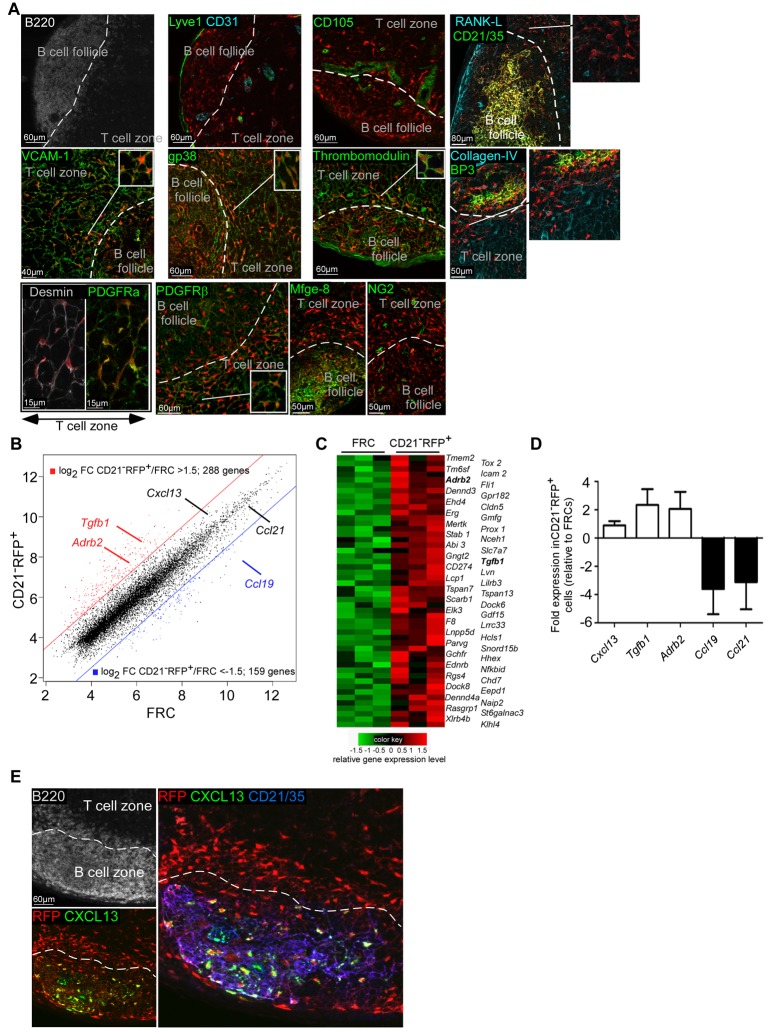
Phenotype of CD21− RFP+ stromal cells.(A and E) Confocal images of a LN section from a CD21cre-RFP chimera stained for the indicated markers. RFP+ cells appear in red. The dashed line delineates B cell follicle boundary. (B, C, D) CD21− RFP− gp38+ CD31− CD45− FRCs and CD21− RFP+ gp38+ CD31− CD45− cells were sorted by flow cytometry and their transcriptomic profiles were analyzed by microarrays (B and C) or RT-PCR (D). (B) Scatter plot of global comparison of gene expression between CD21− RFP+ cells and FRCs. Each gene in the microarray is represented by a dot with coordinates consisting of average gene expression computed from three independent CD21− RFP+ samples (y-axis) and from the three matched FRC samples (x-axis). Genes with Log2 average expression level at least 1.5-fold higher in CD21− RFP+ cells are shown in red, while genes with Log2 average expression level at least 1.5-fold higher in FRCs are shown in blue. These genes are separated from the other genes by colored lines representing these fold change cutoffs. (C) Heat map for the 50 genes with the most significantly higher expression in CD21− RFP+ cells. A subset of the genes shown in red in panel B was further selected based on a p value<0.05 for differential expression between CD21− RFP+ cells and FRCs, as computed by Limma. Genes (rows) and samples (columns) were clustered by complete linkage hierarchical clustering, using Euclidean distance measure. For each gene, expression levels close to the mean value across all six samples are shown in black, high expression levels in red, and low expression levels in green. (D) Relative expression of Cxcl13, Ccl21, Ccl19, Tgfb1, and Adrb2 mRNA levels quantified by RT-PCR. Data are representative of three different experiments (4–5 mice per sample). (E) Confocal images of a LN B cell follicle and its adjacent T cell area from a CD21cre-RFP chimera stained for CXCL13 (green), CD21/35 (blue), and B220 (white). RFP+ cells appear in red. The dashed line represents the delineation of the B220 staining. Data are representative of two different experiments (two mice per experiment).